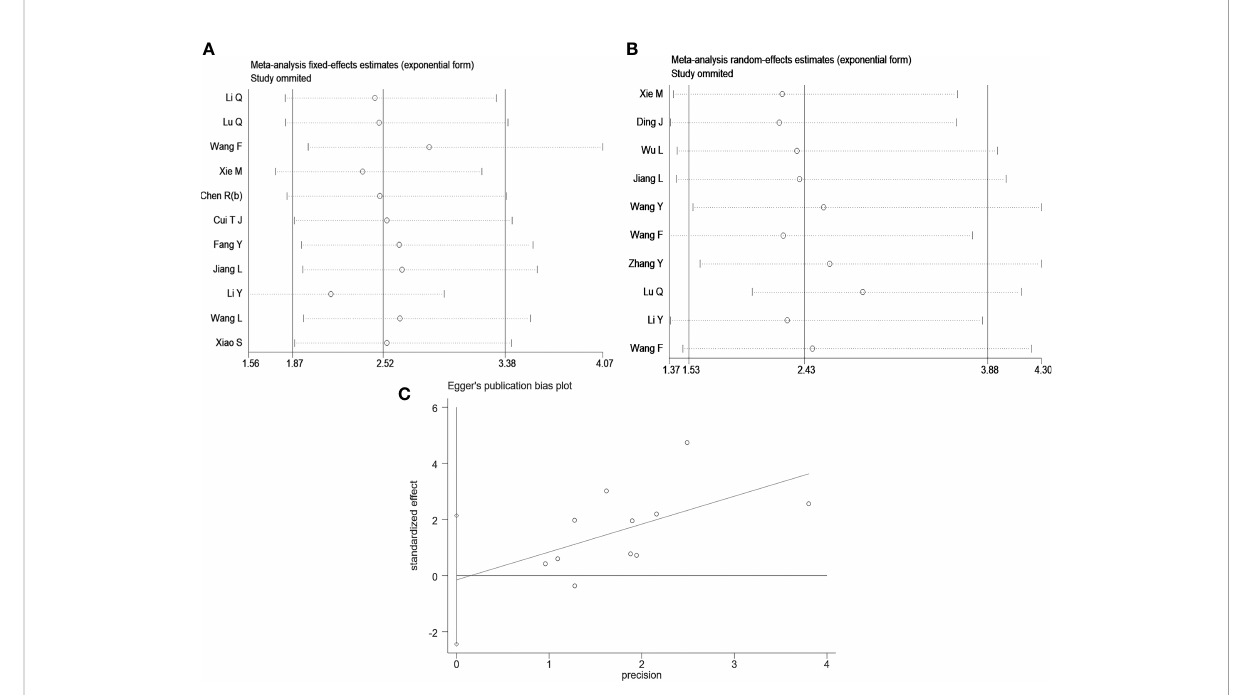
FIGURE 4 Sensitivity analysis and Egger ’ s test. (A) Sensitivity analysis for OS; (B) Sensitivity analysis for tumor size; (C) The Egger ’ s test and linear regression plot for the publication bias for